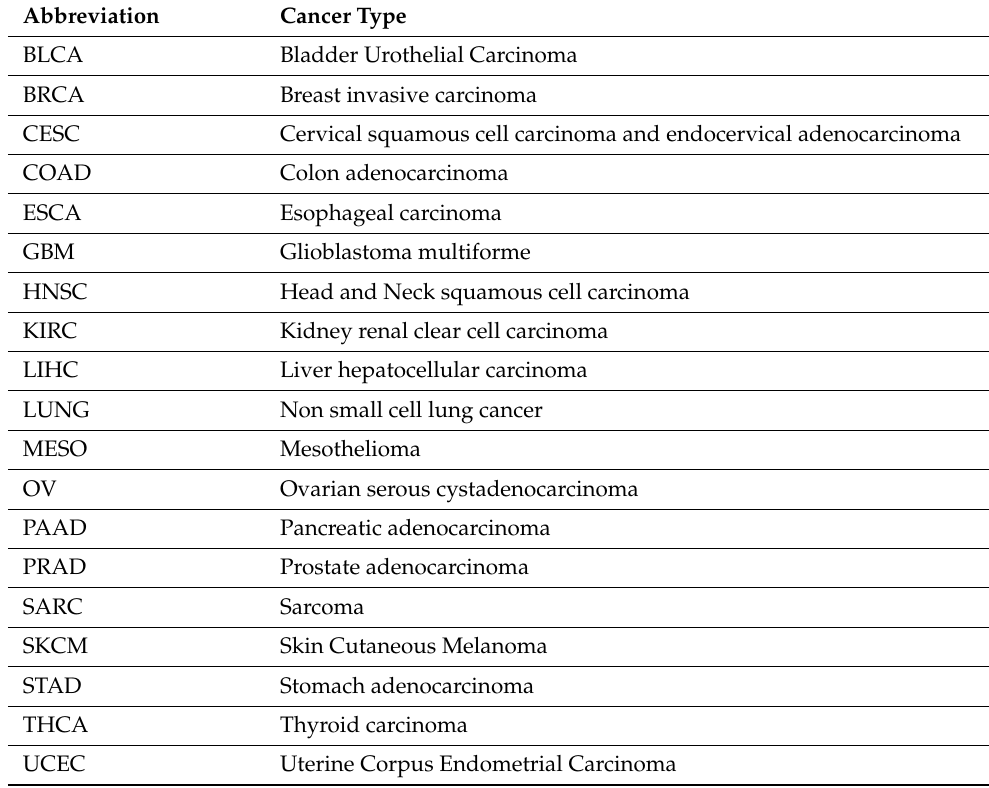
Table 1. Cancer type abbreviations from the Cancer Genome